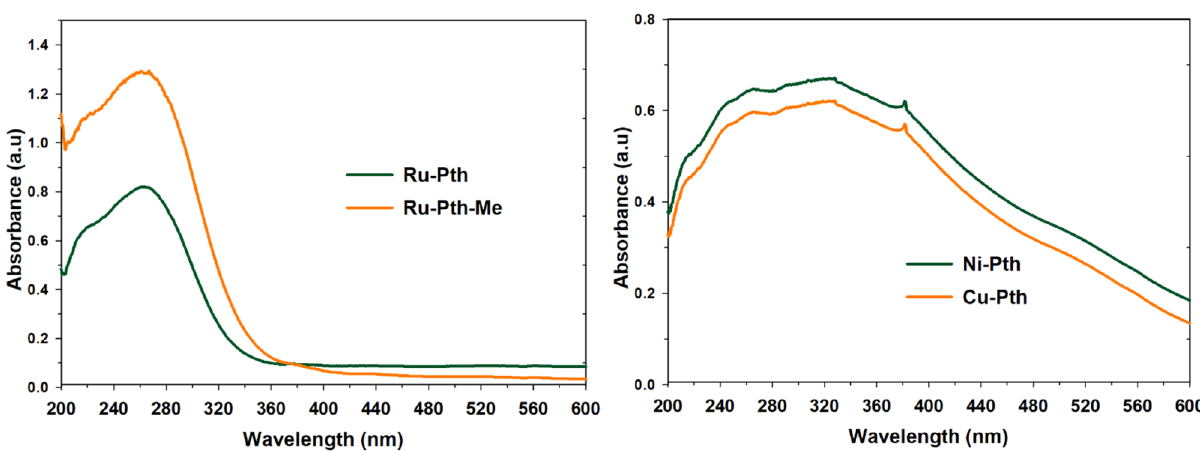
Figure 2. Diffuse reflectance UV–Vis spectra of Ru-Pth, Ru-Pth-Me, Ni-Pth and Cu-Pth